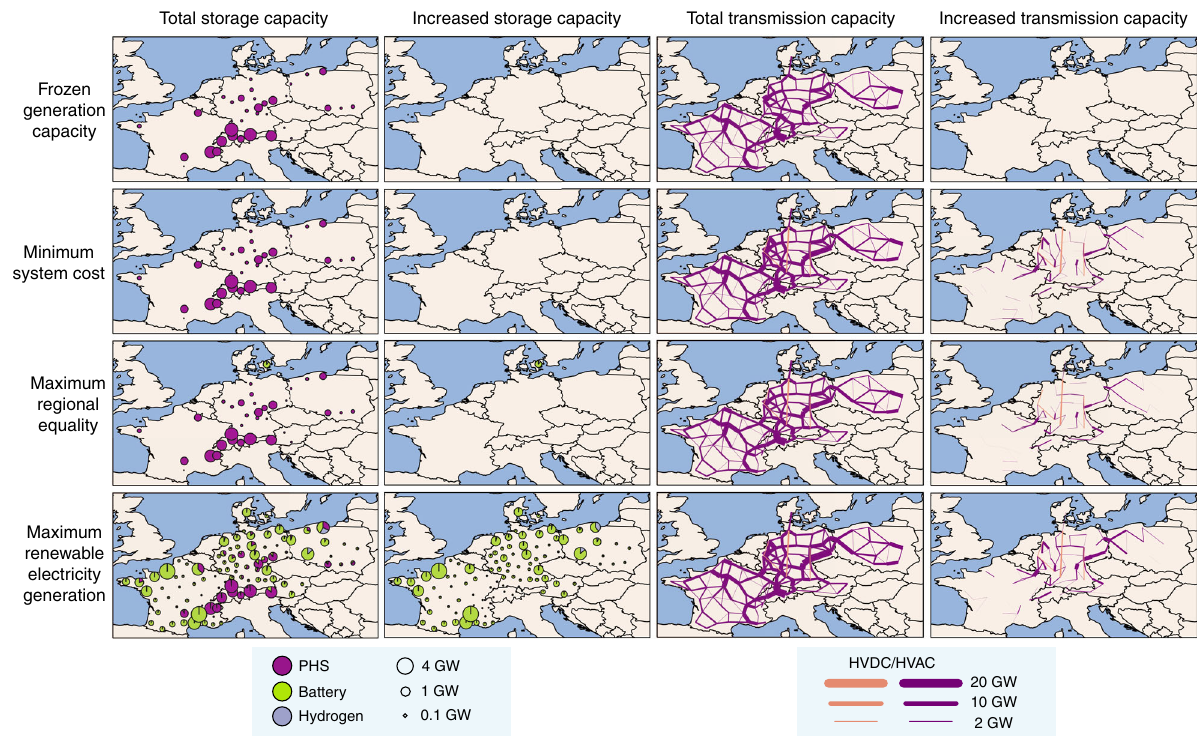
Fig. 3 Regional changes in storage and transmission capacity in 2035. The fi gure depicts total storage and transmission capacity as well as increases in this capacity at each of the 100 grid nodes as compared to 2018 for the four distinct scenarios of frozen generation capacity, minimum system costs, maximum regional equality of system costs, and maximum renewable electricity generation. In the scenarios of minimum system cost, maximum regional equality of system costs, and maximum renewable electricity generation, each country meets its national electricity generation targets for 2035 (see “ Methods ” ). PHS pumped hydro storage; HVDC high voltage direct current transmission line; HVAC high voltage alternating current transmission